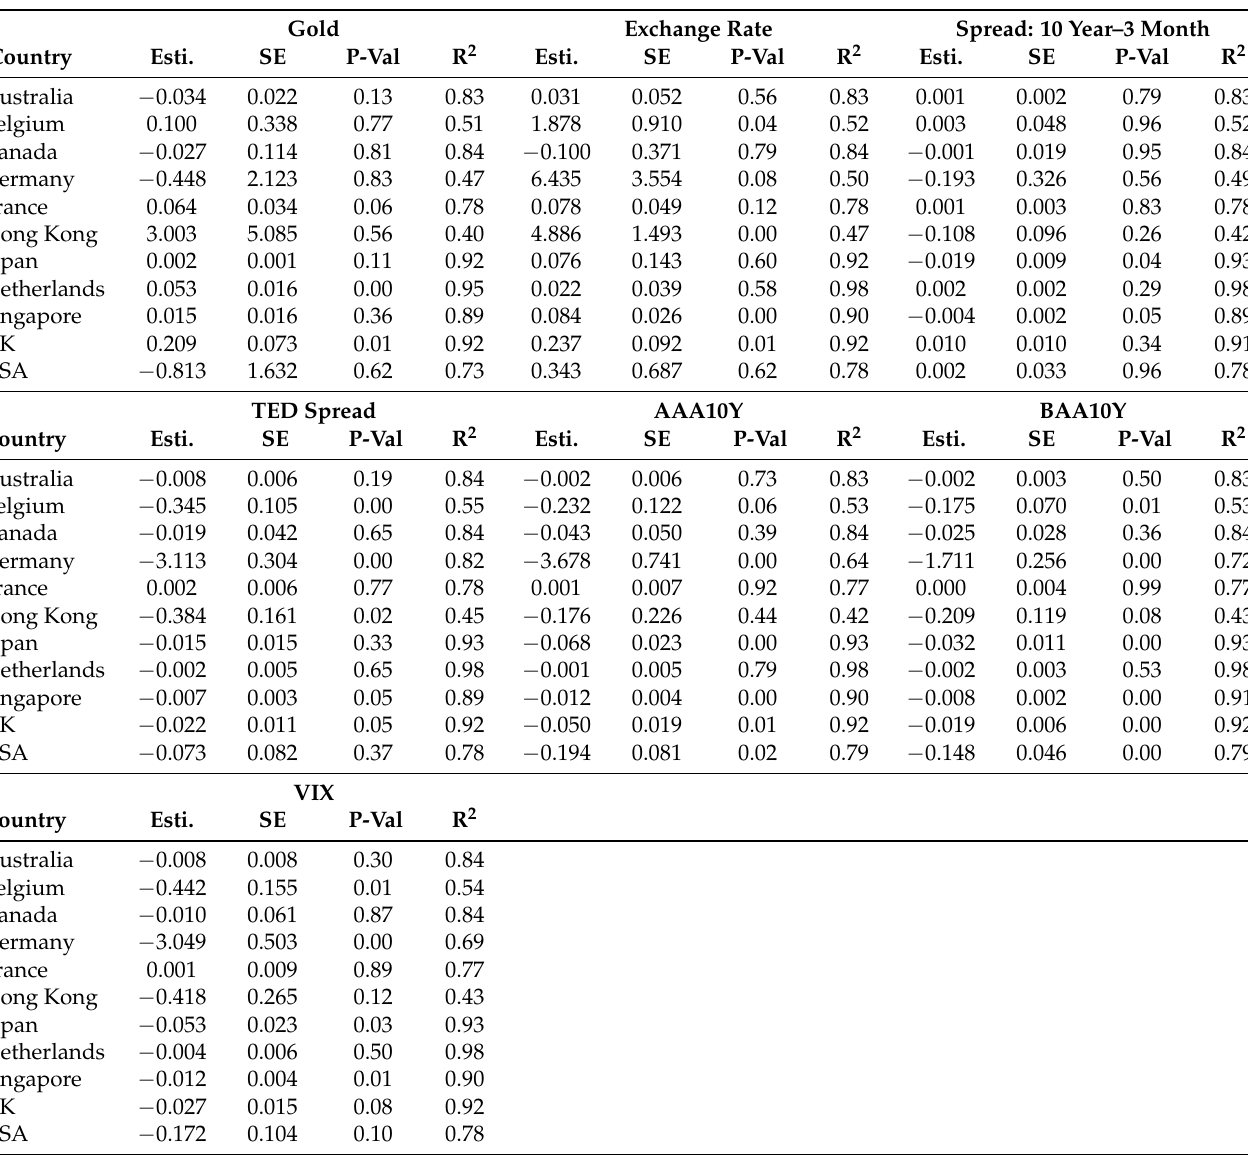
Table 4. The US financial market conditions and time-varying impact of forward guidance shocks. The table presents the impact of the US financial market conditions on time-varying response of international REITs to forward guidance shocks using the OLS model. Given the construction of the TVP model, each regression includes a lag of the dependent variable and a constant. The financial market condition measures include changes in gold prices, exchange rates, US treasury spread between 10-year and 3-month maturity, TED spread, spread between AAA corporate bond and 10-year treasury bond, spread between BAA corporate bond and 10-year treasury bond, and the VIX